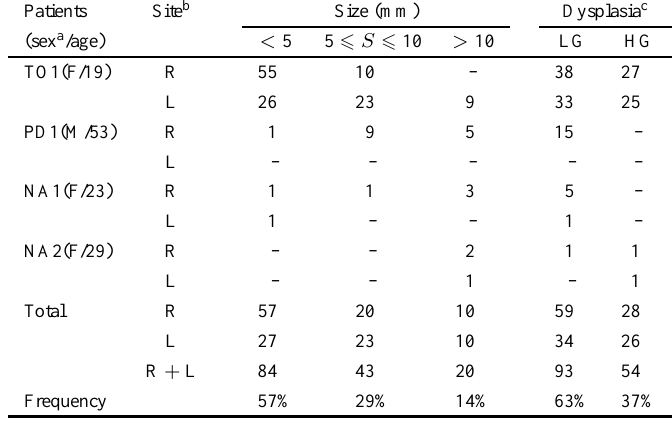
Age, sex, site, size, and dysplasia in 147 adenomas from 4 FAP patients